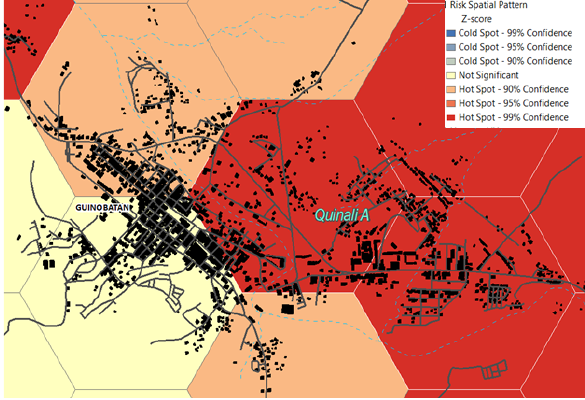
Figure 4. Topophilia-Exposed OSM Buildings in Guinobatan